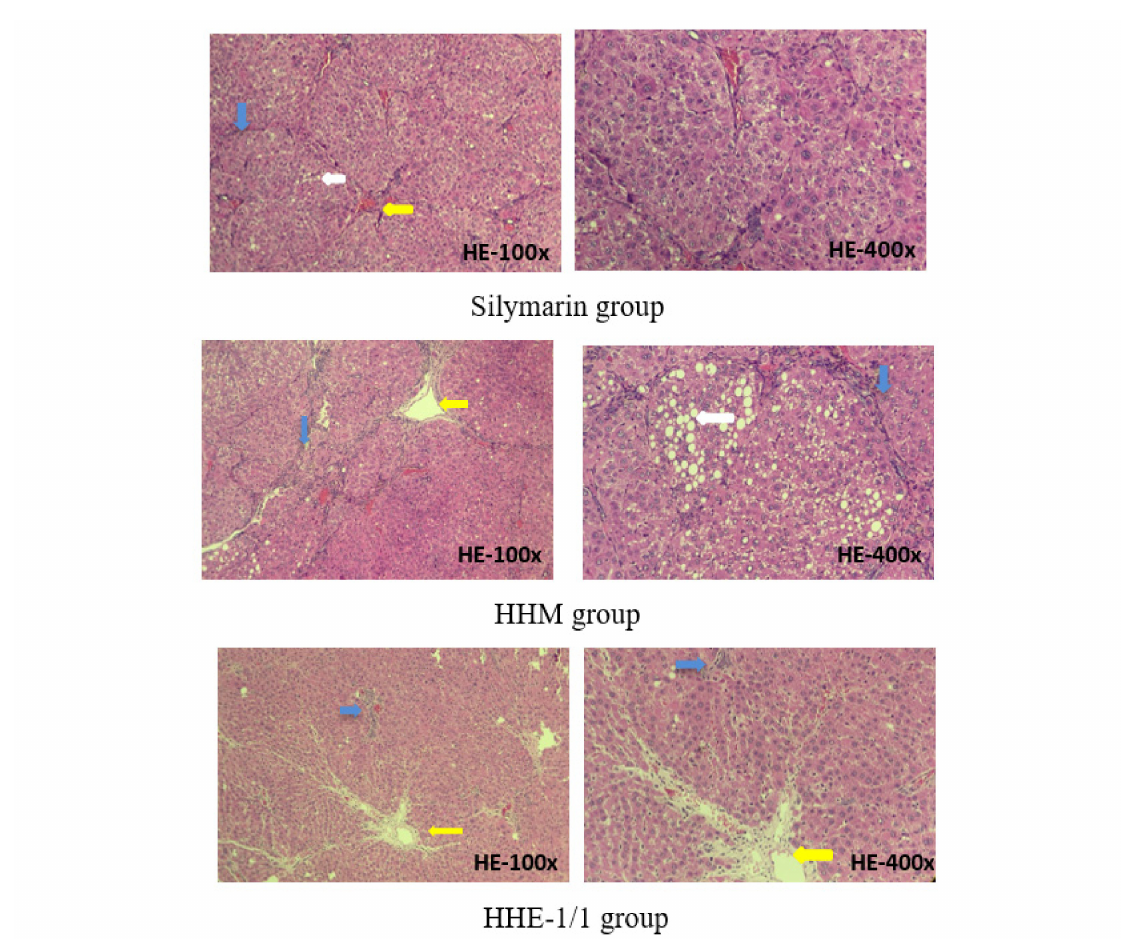
Figure 4. Photomicrographs of rat liver in silymarin, HHM, HHE-1/1 groups stained with hematoxylin-eosin. Photomicrographs of a liver of the CCl 4 group stained with Masson show (A) a significant increase in collagen (blue) separated the liver lobes to pseudo lobes. The livers of silymarin, HHM, and HHE-1/1 groups appear as short bands of collagen that extended the portal areas. There were no pseudo lobes in the liver parenchyma (Figure 5). Image analysis by ImageJ software showed the blue area represented by the collagen fiber area in the CCl 4 group. The rate of the collagen invasion area accounted for 19.9% while measurements of the collagen area of the silymarin, HHM and HHE-1/1 groups were 1.19%, 3.44%, and 5.12%,